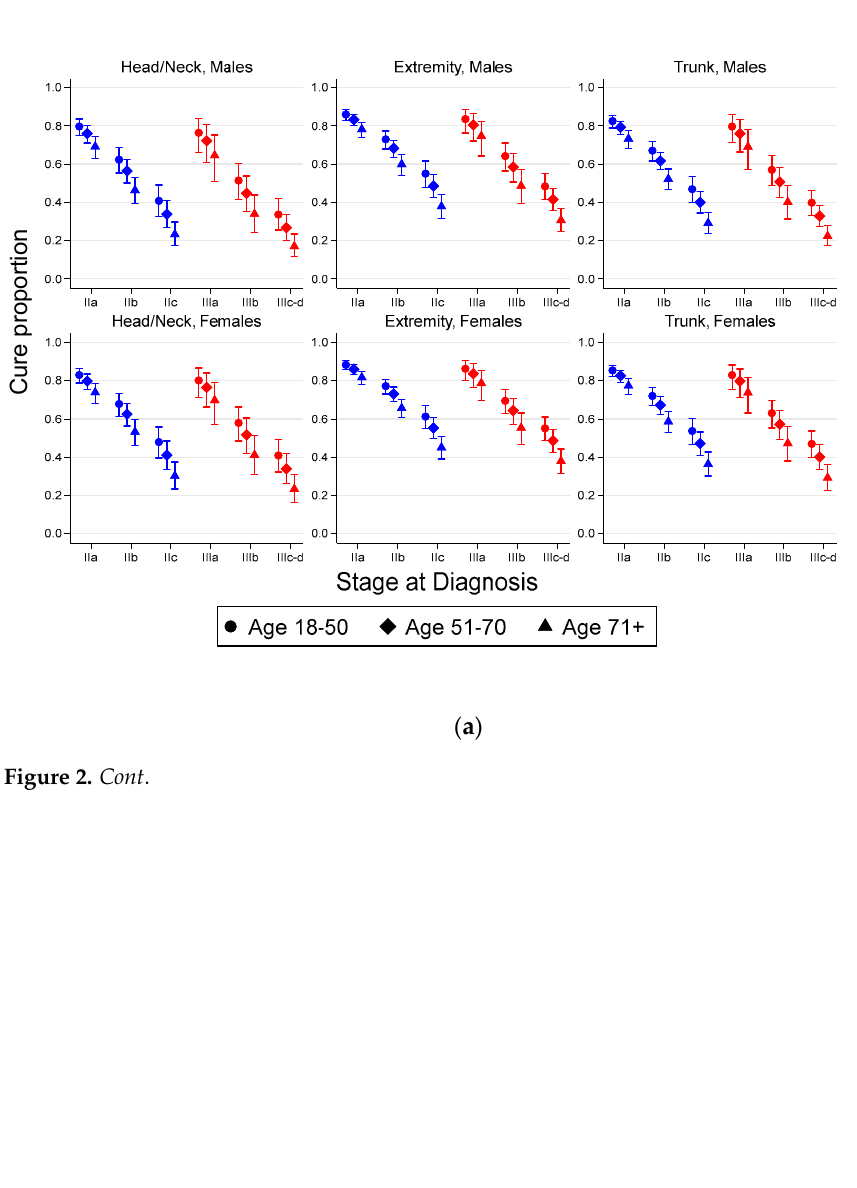
* Reference: Stage IIA for the stage II cutaneous melanoma group and stage IIIA for the stage III cutaneous melanoma group.